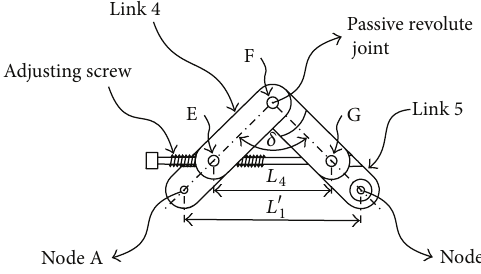
Figure 6: The variable length crank link